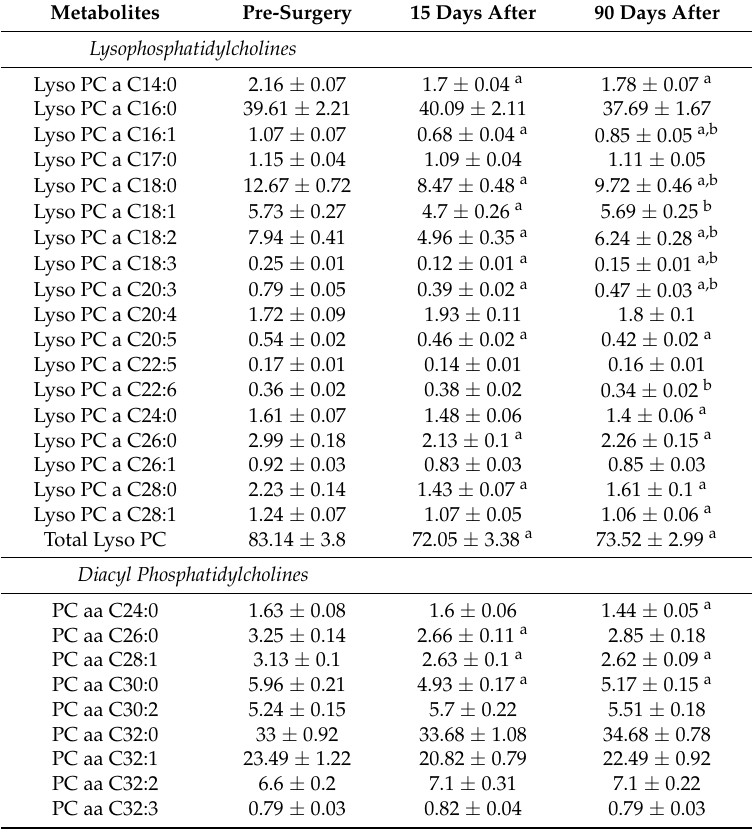
Table A3. Glycerophospholipids and sphingomyelins concentration ( µ M) in dried blood spots collected from patients before, 15 days and 90 days after RYGB surgery. a p < 0.05 compared to pre-surgery. b p < 0.05 compared to 15